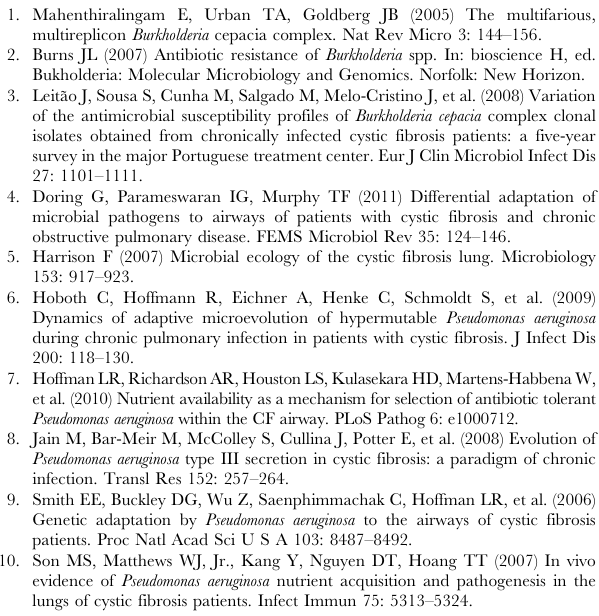
Figure 1. Genes specific of the AU1054 strain are shaded in grey. Table S4 List of genes having an altered expression in B. cenocepacia variants IST439 and IST4113 that are documented to be regulated by CciR. The microarray dataset was searched for genes documented to be activated or repressed by the CciR transcription factor using the results of O’Grady et al ., (2010). Table S5 Proteins found in the membrane-enriched fraction and in the cytosolic fraction whose content was increased (above 1.5-fold) or decreased (below 0.7-fold) in the proteome of B. cenocepacia IST4113 cells, compared to the values registered in B. cenocepacia IST439 (Madeira et al ., 2011). The genes predicted to encode these proteins are also indicated and those found to be differently expressed in the two variants, based on the results of the microarray analysis carried out in this study, are highlighted in